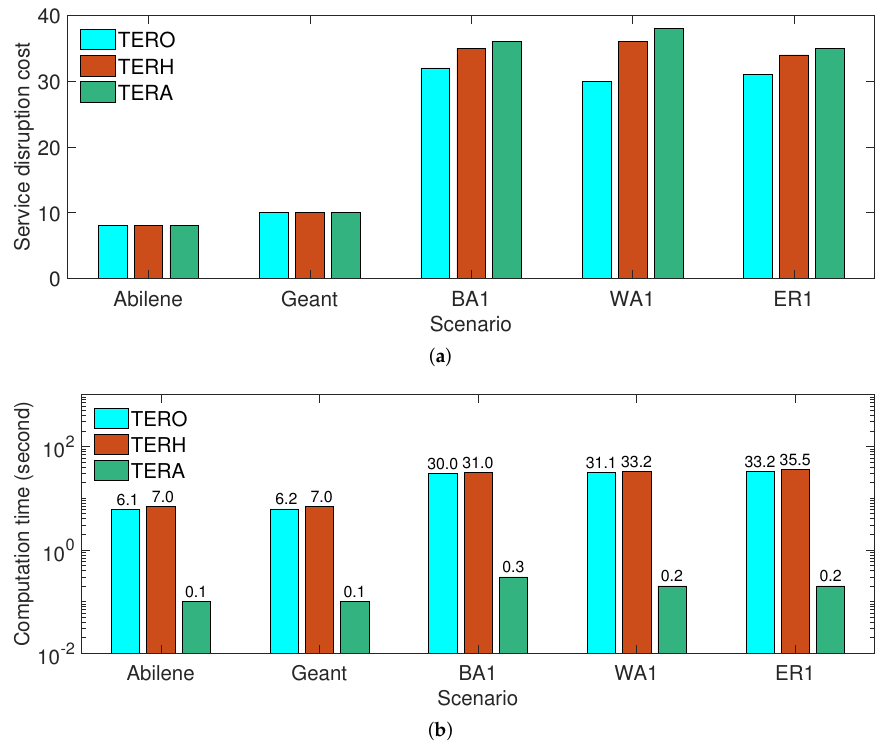
Figure 3. Performance comparison of TERO, TERH and TERA when a failure is changed. ( a ) Service disruption cost; ( b ) Computation